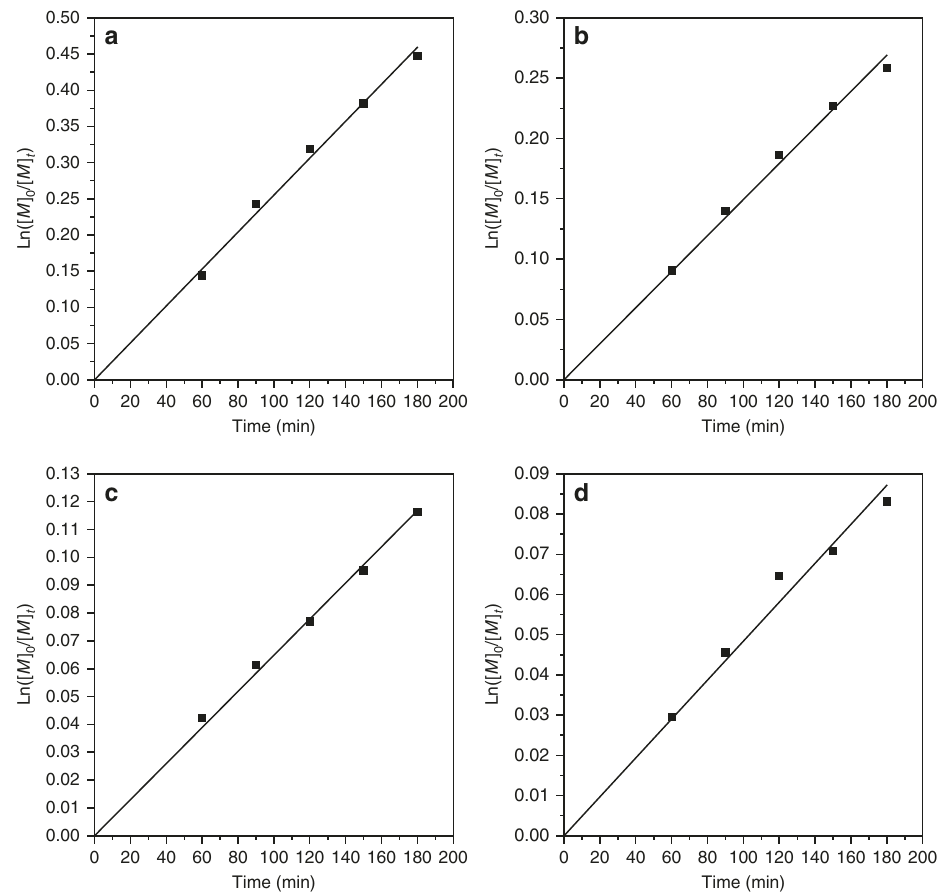
Fig. 4 ATRP kinetics. Kinetic plot for ATRP of EA a , DMAEA b , St c and PFMA d initiated by PBAA